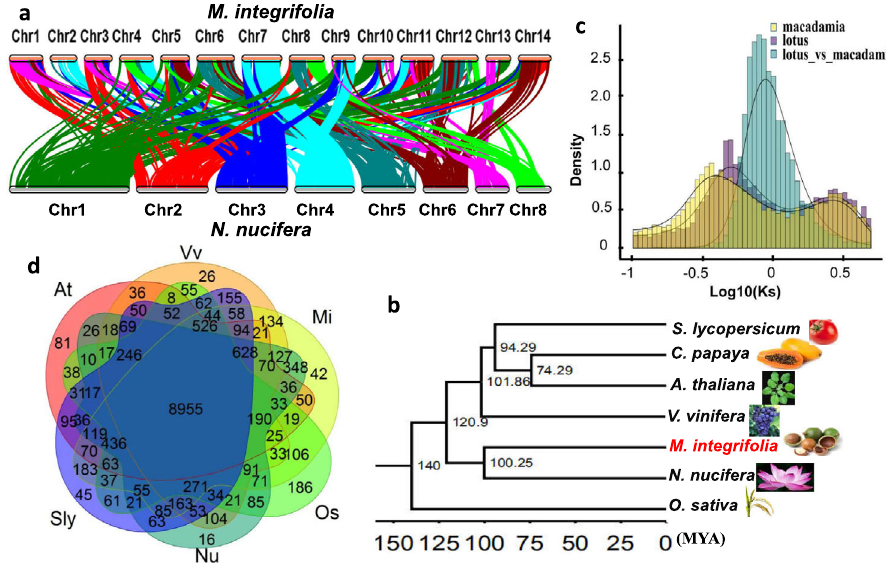
Fig. 2 Evolutionary comparison and gene conservation of the macadamia ( M. integrifolia ) genome. a Inter-genomic comparison between M. integrifolia and N. nucifera . b Inferred phylogenetic tree across seven plant species including macadamia, calibrated using the divergence time of A. thaliana and C. papaya (68 – 72 million years ago) and monocot and eudicot (120 – 140 million years ago) as calibrators. c Synonymous substitution rate ( K s) distributions of syntenic blocks for M. integrifolia and paralogs and orthologs with N. nucifera as shown by colored lines. d Shared gene families among At = A. thaliana , Os = O. sativa , Sly = S. lycopersicum , Vv = V. vinifera , Nu = N. nucifera , and Mi = M. integrifolia . The six species contain 8955 common gene families, and M. integrifolia has 42 speci fi c gene families.